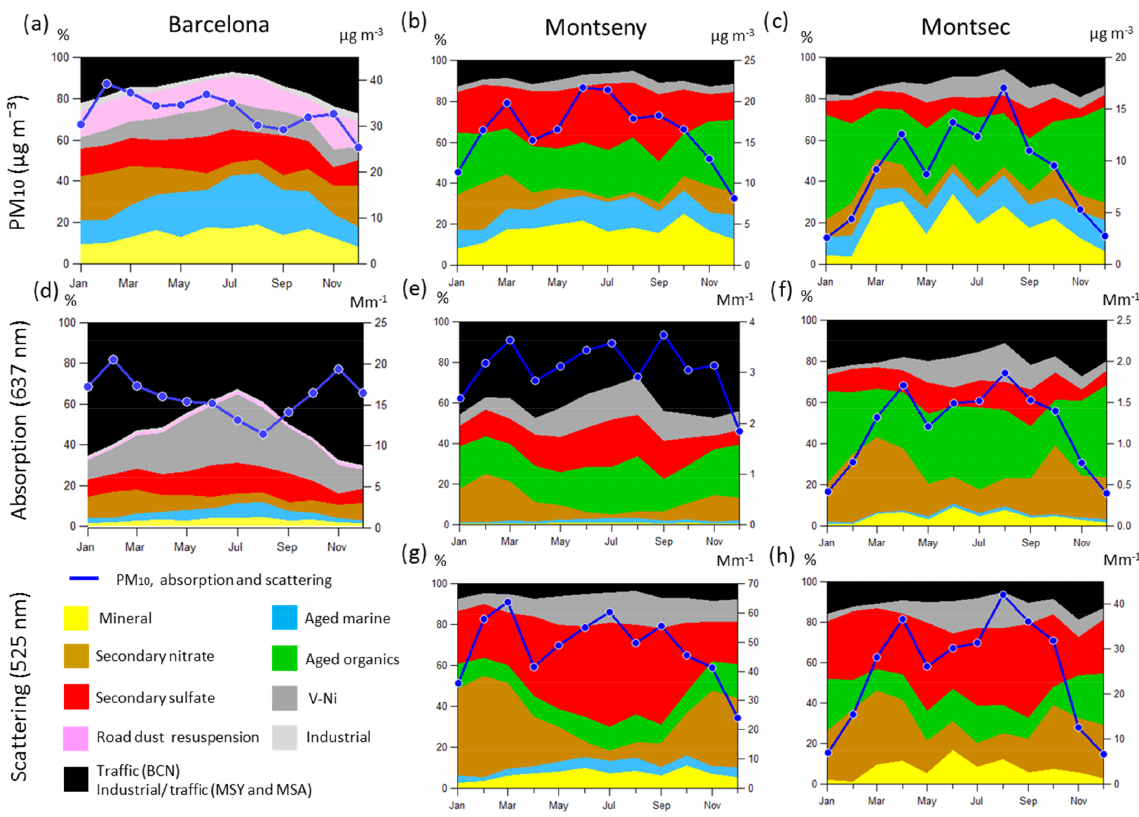
Figure 3. Relative (%) monthly average source contribution to PM 10 concentration (µgm − 3 ) at (a) BCN, (b) MSY and (c) MSA, absorption (Mm − 1 ) at 637nm ( d , e and f ) and scattering (Mm − 1 ) at 525nm (g, h) . PM 10 source contributions were obtained from the PMF model, whereas scattering and absorption contributions were modelled by means of the PMF–MLR technique. The study period ranges between 2004–2014 at BCN and MSY and between 2010–2014 at